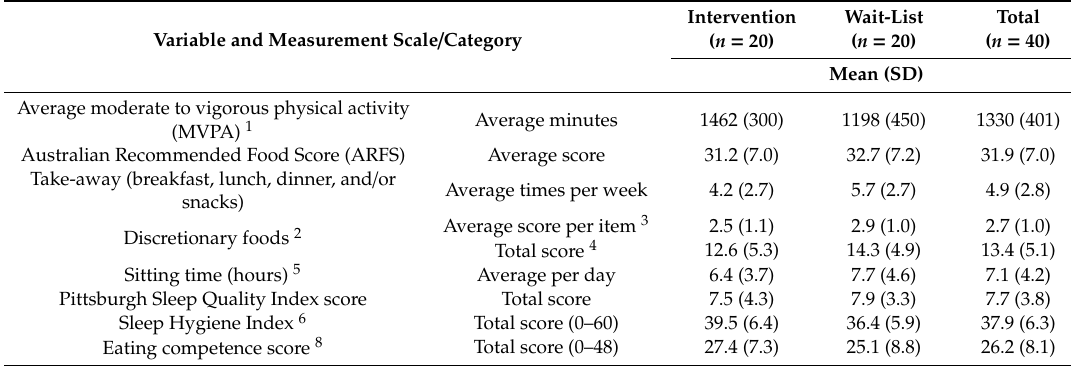
Table 2. Health behavior indicators for shift-worker Move, Eat, and Sleep participants at baseline ( n =